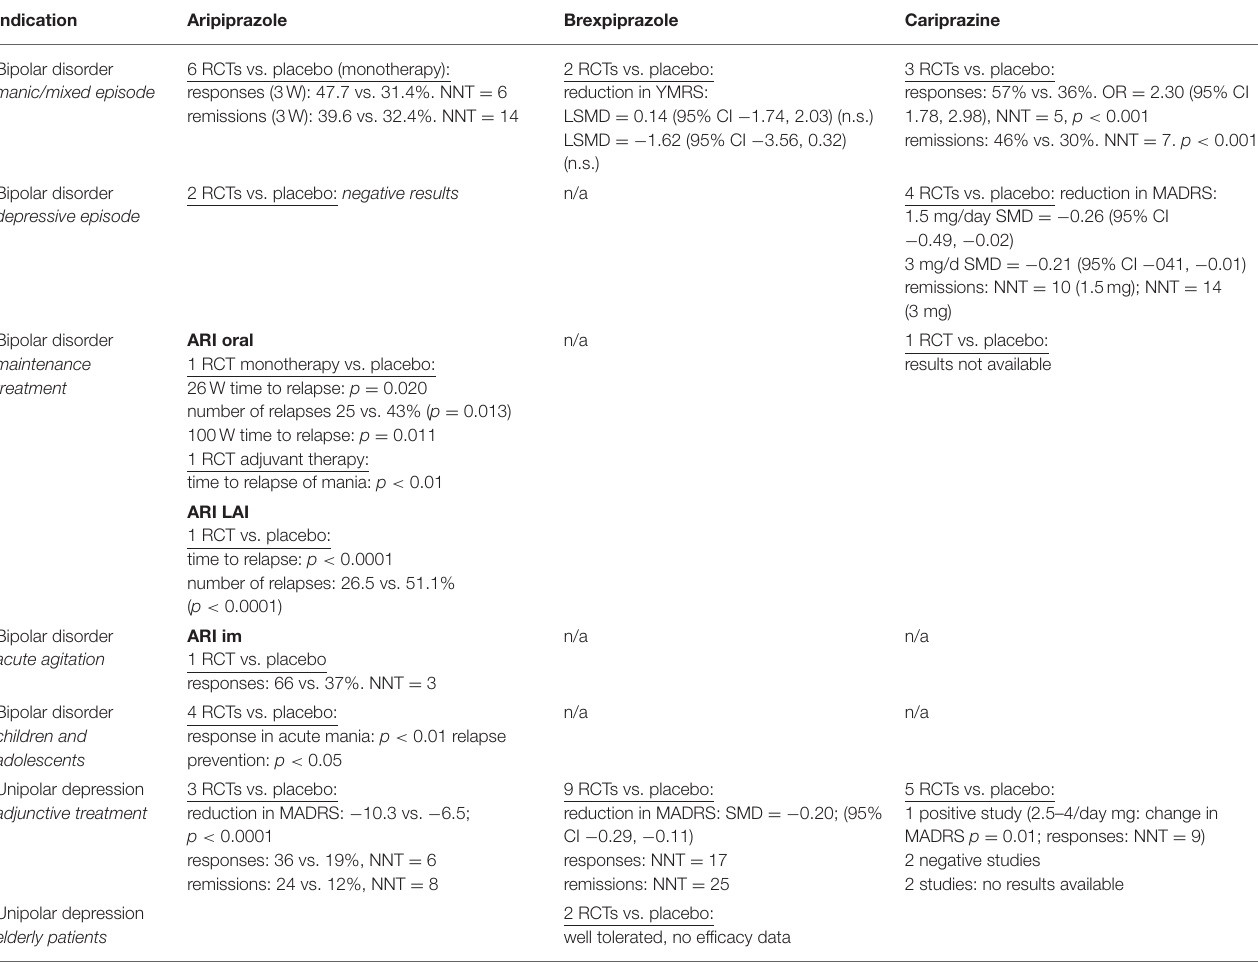
TABLE 3 | Randomized double-blind trials of DRPAs in mood disorders. Indication Aripiprazole Brexpiprazole Cariprazine Bipolar disorder manic/mixed episode